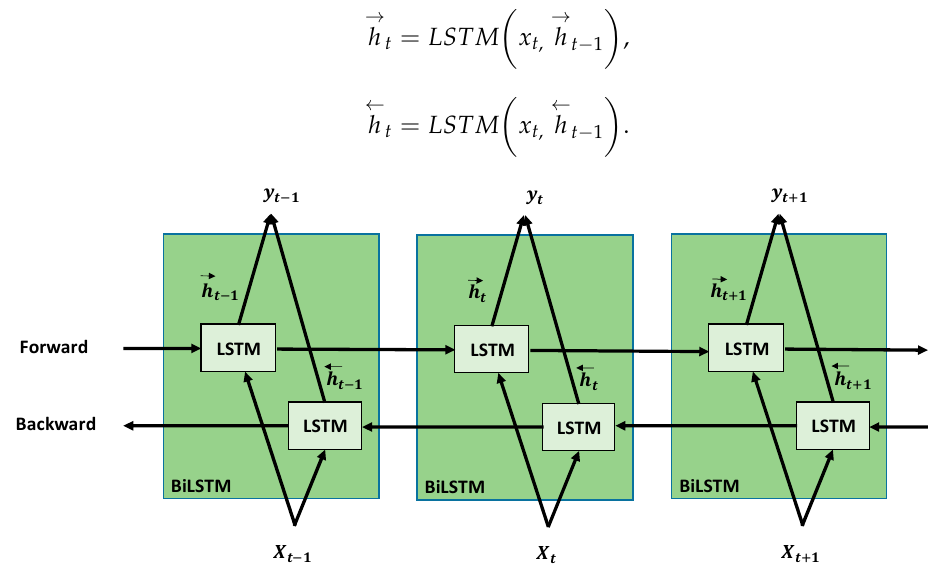
Figure 5. Architecture of bidirectional long short-term memory (BiLSTM).